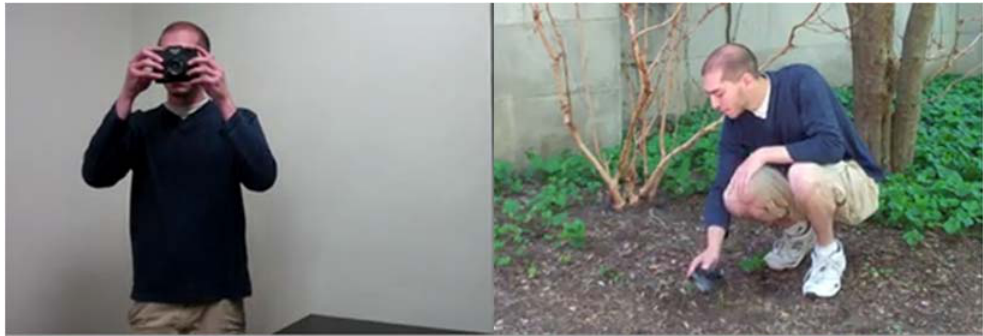
Figure 1. Example of scenes used in the study. ( Left ) a typical-use scene showing a person taking a photo with a camera. ( Right ) an atypical-use scene, showing a person digging with a camera. Participants completed the experiment in individual experiment booths for the dura- tion of the experiment. The experiment was run on an Apple Thunderbolt monitor, attached to an Apple Macbook Air laptop. Video recording was done using a Logitech webcam, also attached to the laptop, and the experiment ran using Psychopy (Peirce 2007).